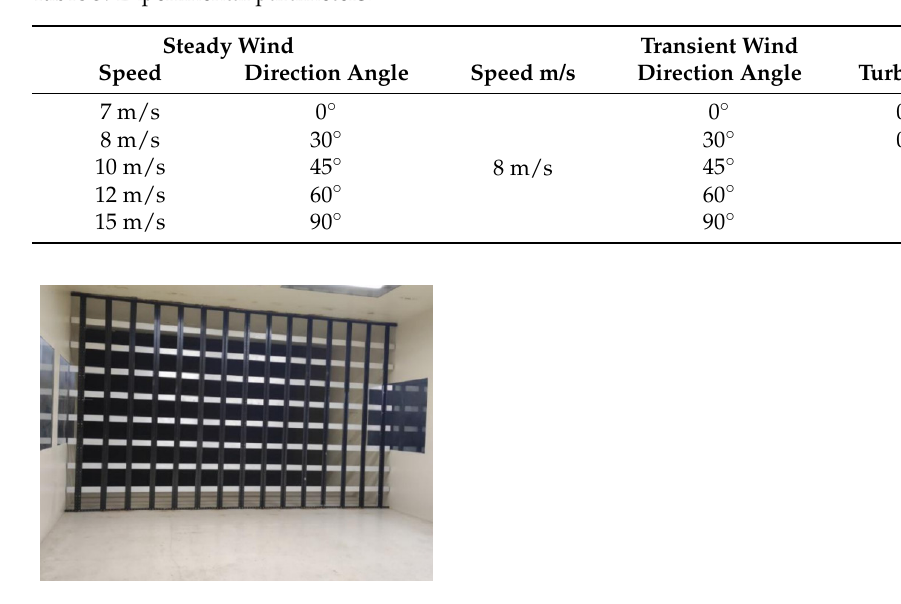
Figure 14. The meshing grilles.